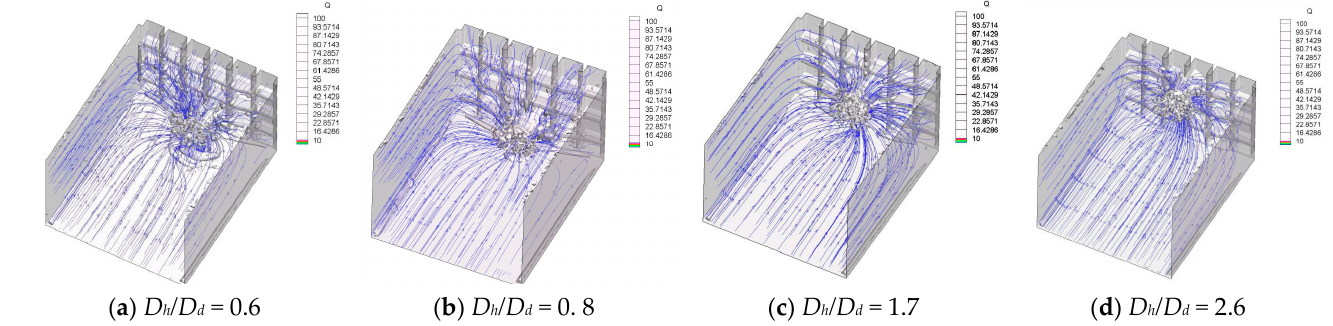
Figure 14. Suction sump three-dimensional vorticity diagram (unit:s − 1 ).